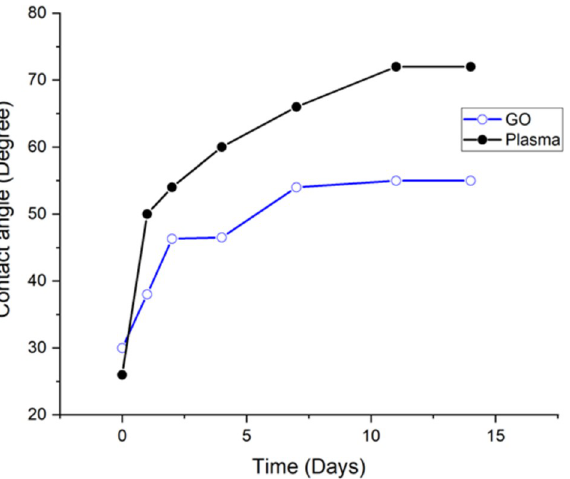
Fig 5. The change in water contact angle over time for plasma-treated (1 minute with HPP) and GO-coated COC substrates (1 mg/ml GO concentration). Both substrates were kept in dark area and at room temperature during the